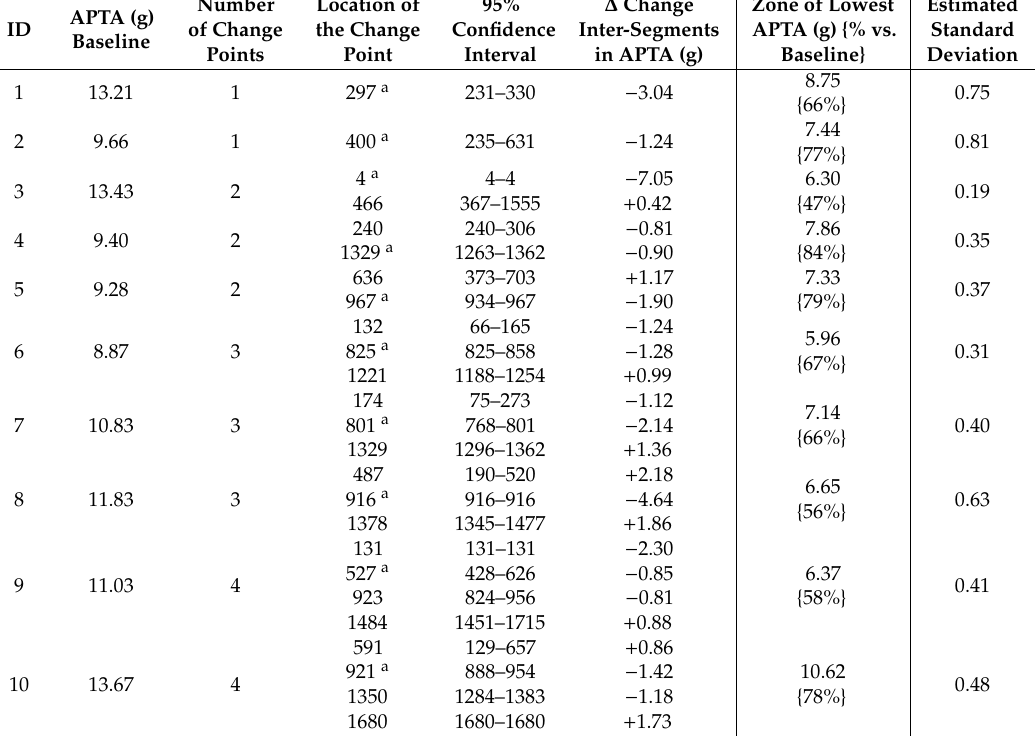
Table 2. Detected change points in the runners with high axial peak tibial acceleration (APTA). Each row represents a subject. Subjects are sorted according to the number of detected change points, and then, according to the timing of the first change in APTA. The individual location corresponds to the detected APTA in the biofeedback condition. The + and – signs indicate an increase and a decrease, respectively, in the APTA. a indicates the change in the APTA signal that corresponds to the major decrease in magnitude as identified by the Change-Point Analyzer. The estimated standard deviation of the grouped APTA is based on the whole running